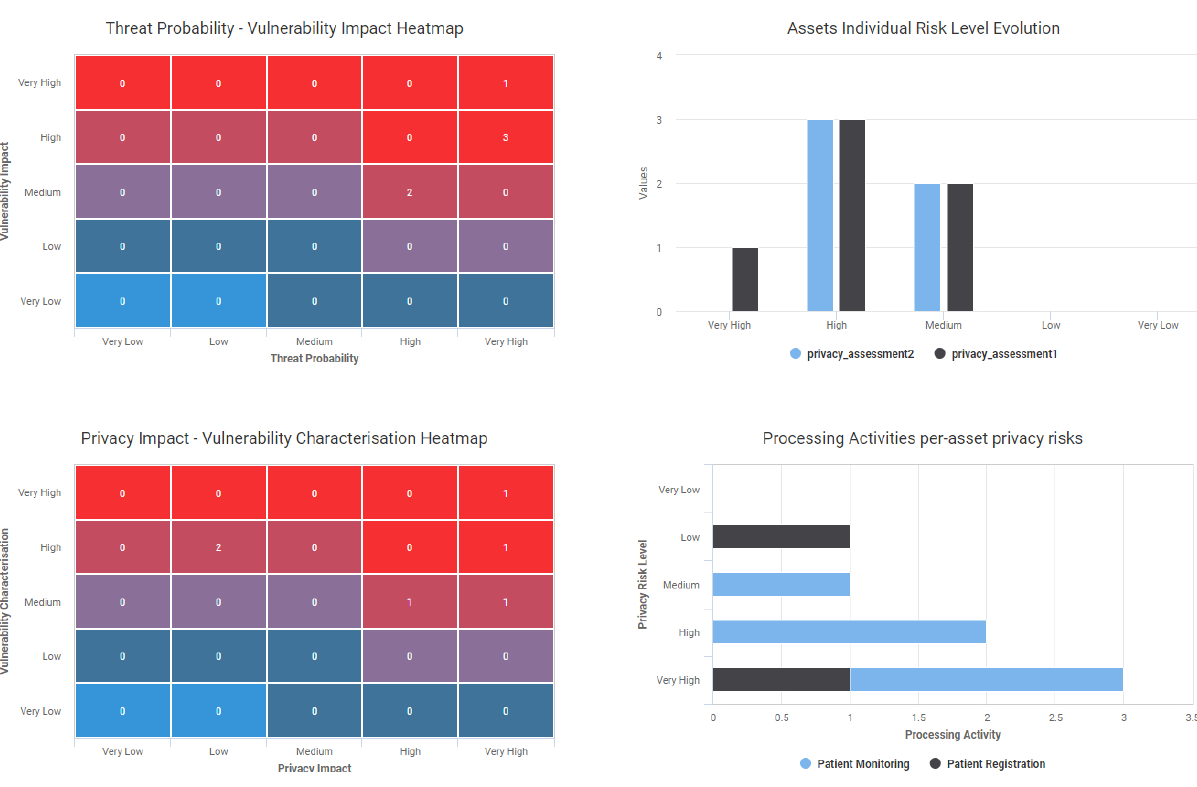
Figure A4. APSIA Dashboard heat-maps and